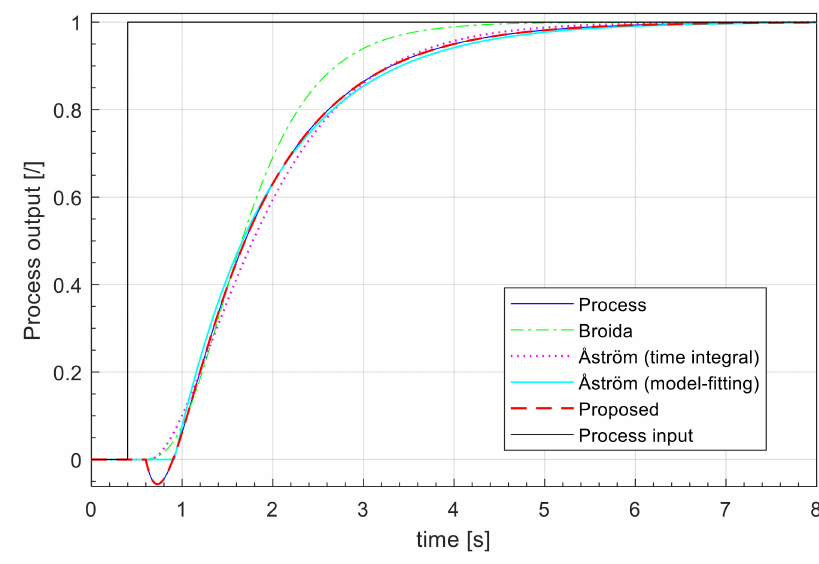
Figure 7. The step-change responses for process G P1 .